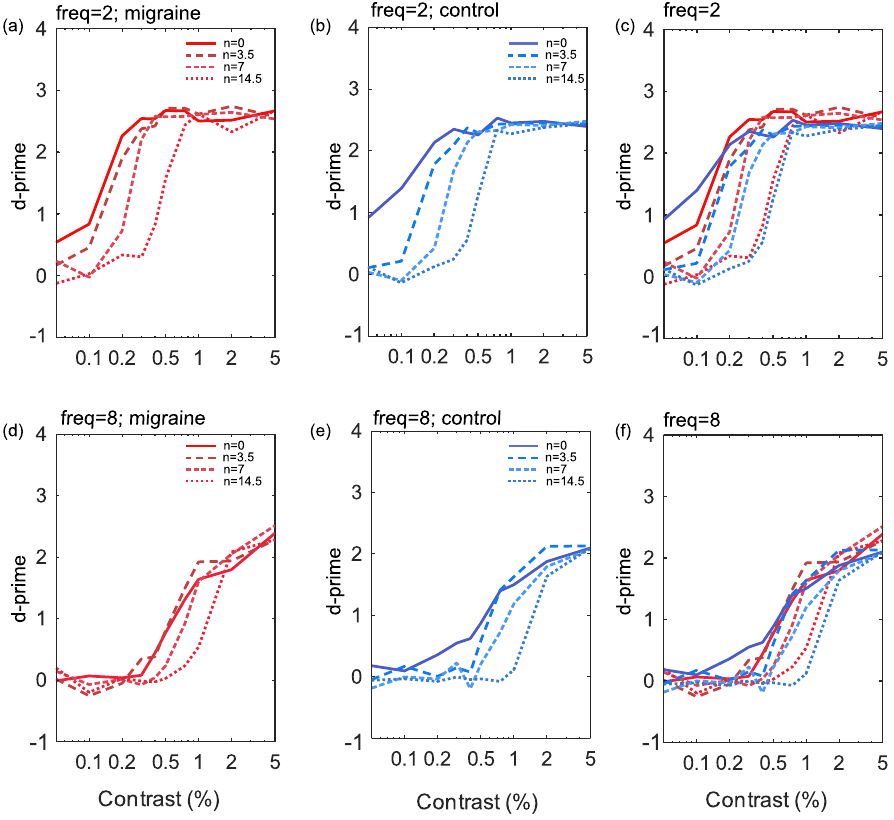
Figure 3. The results showing percentage Michelson contrast spatial frequency against d’ (sensi- tivity) for the 2 cpd stimuli ( a – c ) and the 8 cpd stimuli ( d – f ). Noise is plotted for each of the four levels independently for control ( b , e ) and migraine groups ( a , d ) and finally combined groups ( c , f ) by